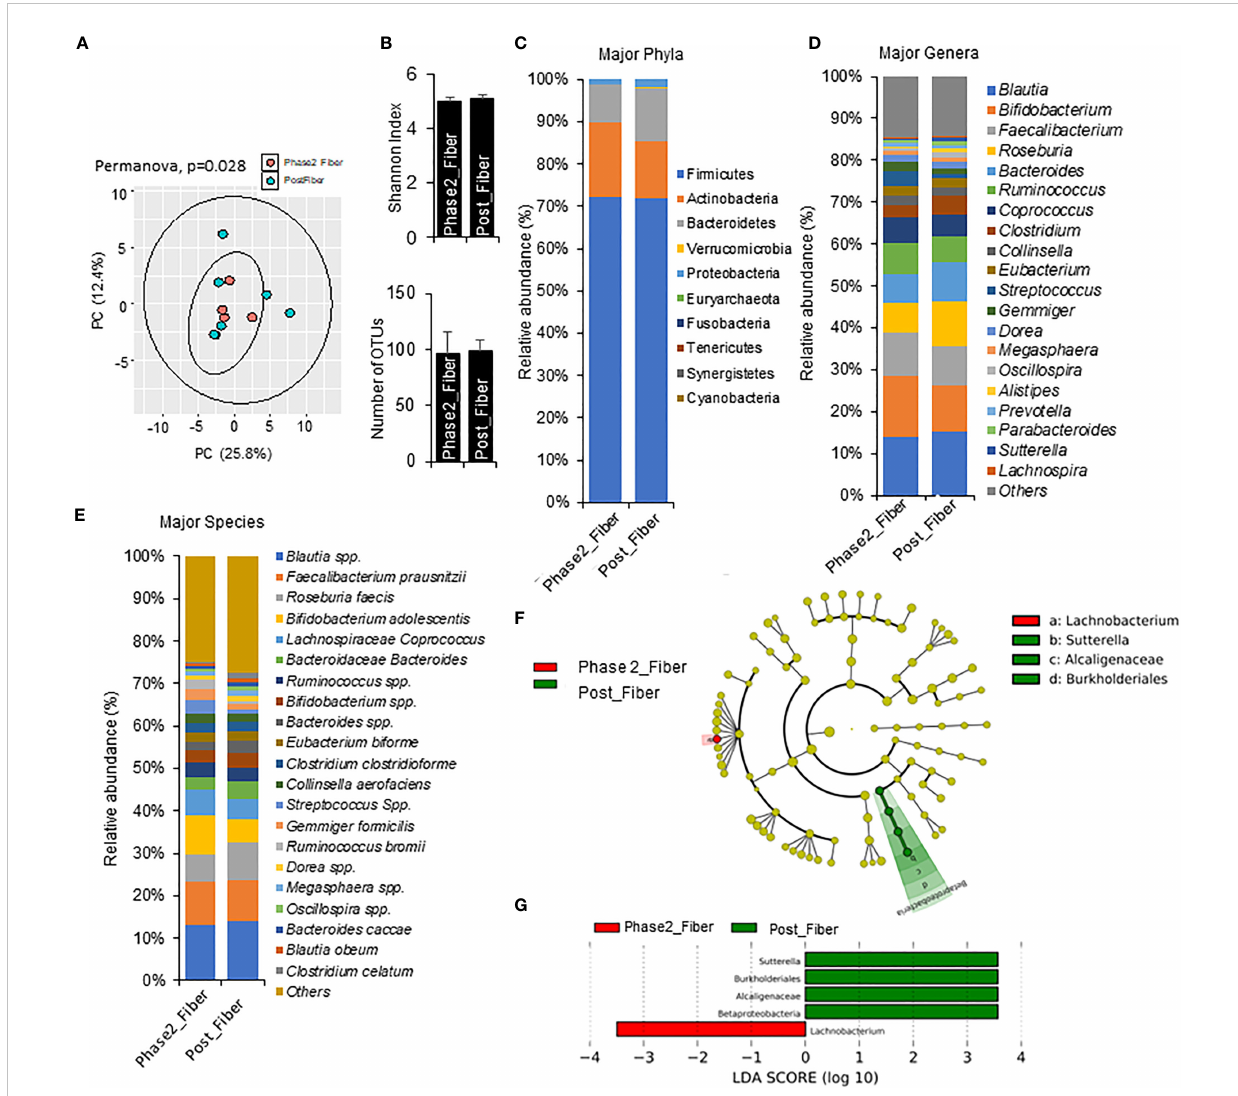
FIGURE 6 Microbiome signatures in Phase 2 prebiotic/metformin compared to Phase 1 prebiotic/metformin. (A) Principal component analysis of beta-diversity showed that microbiota composition differed between Phase2_Fibre (Phase 2 prebiotic/metformin) and Post_Fiber (Phase 1 prebiotic/metformin). (B) The a -diversity measure, Shannon Index and number of OTUs showed no differences between groups. (C – E) There were modest changes in abundance of major phyla, genus, and species. (F, G) LEfSe (Linear discriminant analysis Effect Size) analysis in Phase2_Fiber vs Post_Fiber showed unique biomarkers. Data are mean and standard error of mean. Microbiome beta-diversity was assessed using the Bray-Curtis dissimilarity index and visualized with principal component analysis. The a -diversity indices and bacterial proportions were compared using the Kruskal-Wallis test followed by the Mann-Whitney multiple pairwise comparison